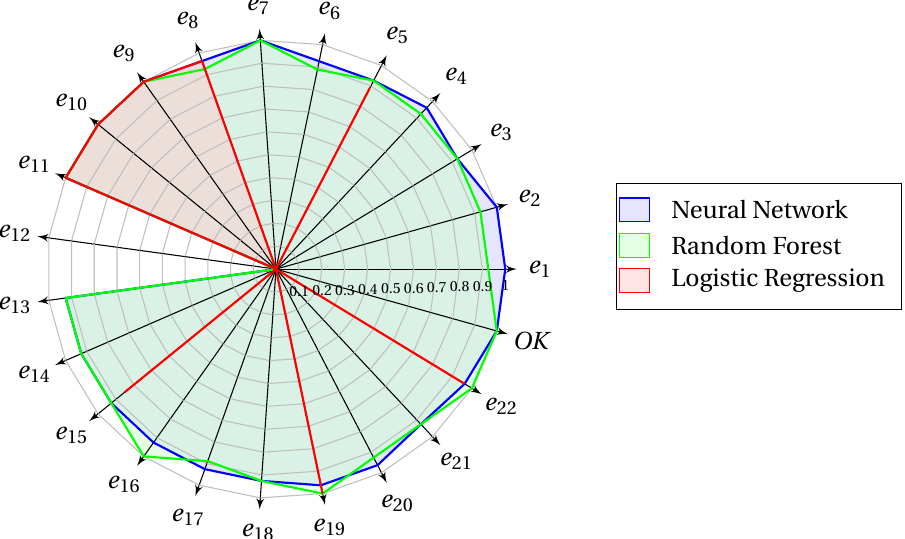
Figure 12. Comparison of the results of 3 applied methods machine learning in terms of recall.